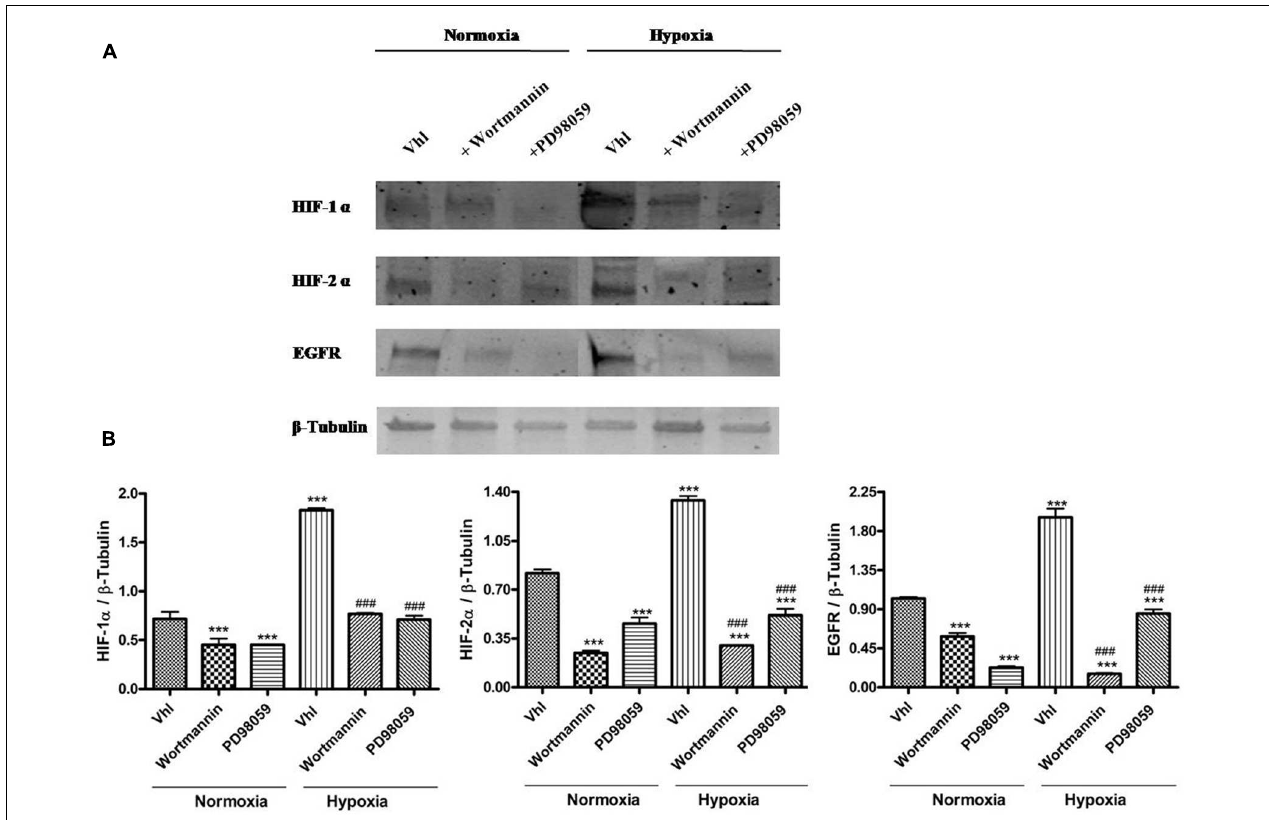
FIGURE 5 | Expression of HIF-1 α , HIF-2 α , and EGFR following inhibition of PI3K/Akt or MAPPK/Erk kinase signaling pathway. (A) Representative immunoblot of HIF-1 α , HIF-2 α , and EGFR expression on U87MG cells treated with 10 µ M Wortmannin or with 50 µ M PD98059 and grown normoxia or exposed to hypoxia. (B) Relative density of each band was quantified using ImageJ software. Each signal was normalized on correspondent β -tubulin signal. Data are expressed as mean ± SEM ( ∗∗ p < 0.01 and ∗∗∗ p < 0.001 vs. Vhl under normoxia; ### p < 0.001 vs. Vhl under hypoxia as determined by one-way ANOVA followed by the Tukey post hoc